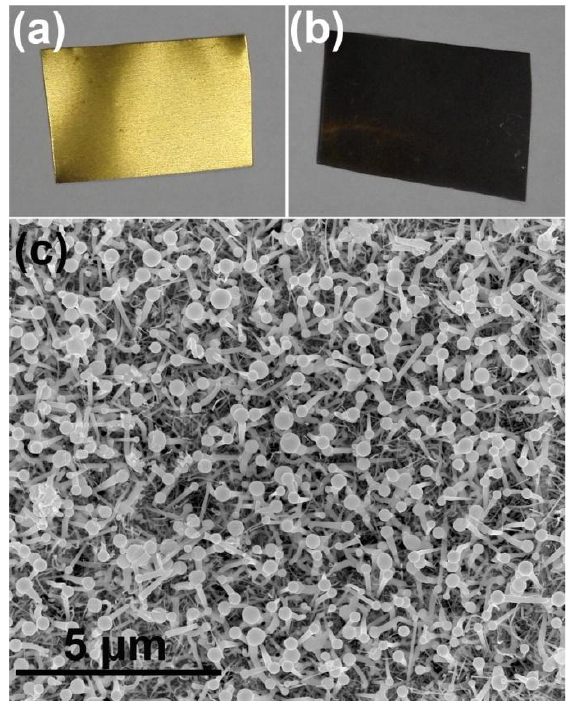
Figure 1. InN nanowires grown on the brass substrates. ( a , b ) Digital photographs of the brass substrate before and after nanowire growth. ( c ) Bird view scanning electron microscopy (SEM) image of the InN nanowires.